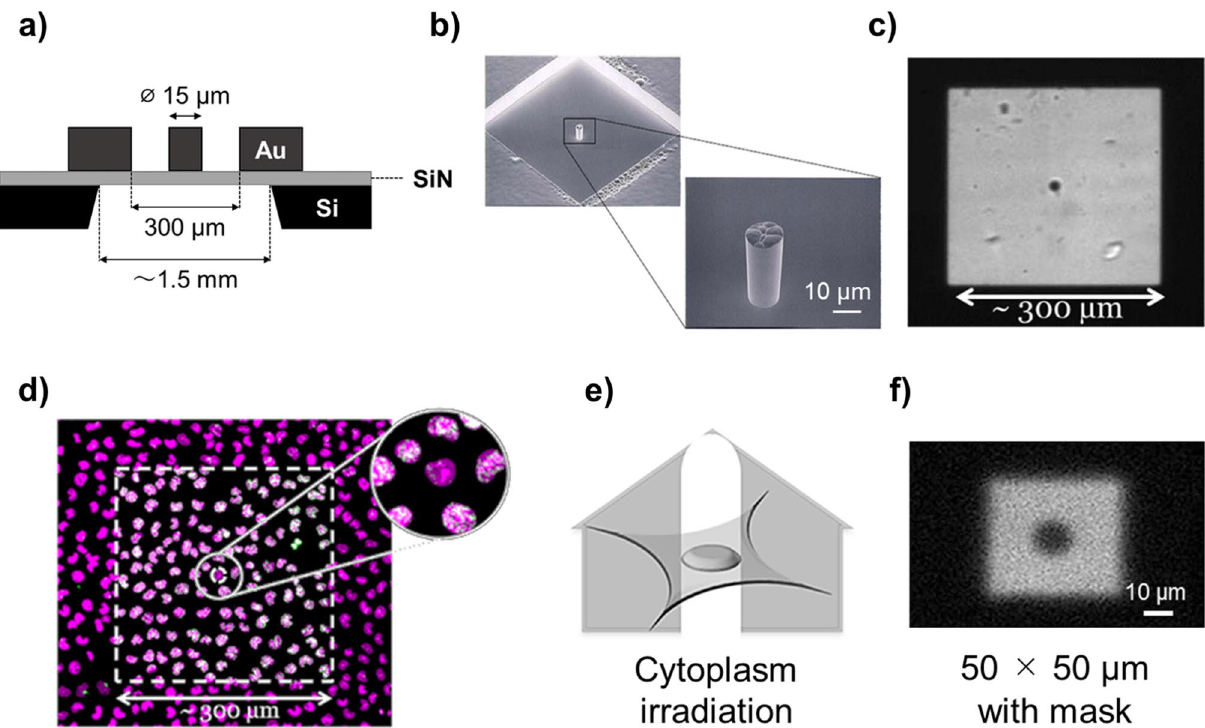
Figure 1. A method for cytoplasm irradiation using synchrotron radiation X-ray microbeams. ( a ) Cross- sectional illustration of a custom-designed X-ray mask. ( b ) Scanned electron microscopy analysis showing